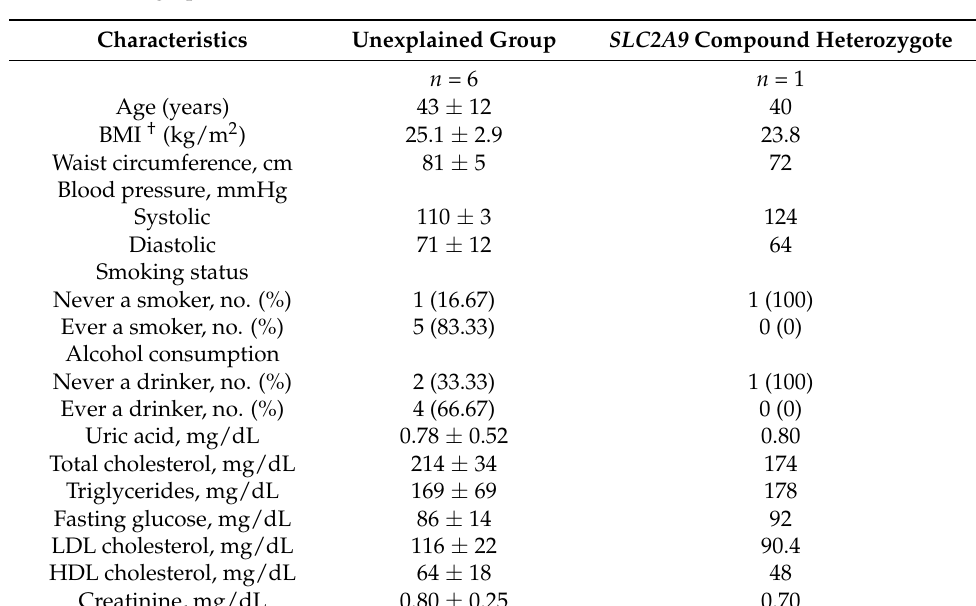
Figure 1. SLC2A9b model structure overview. Table 1. Demographic